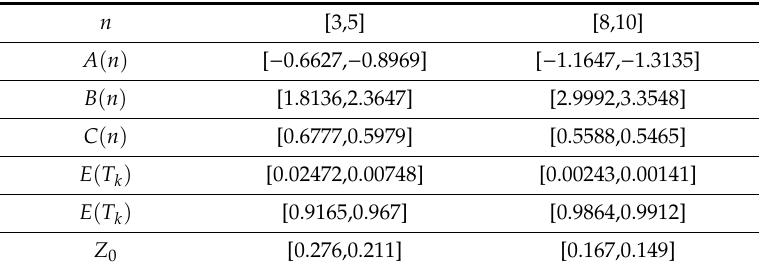
Table 1. The values of constants.